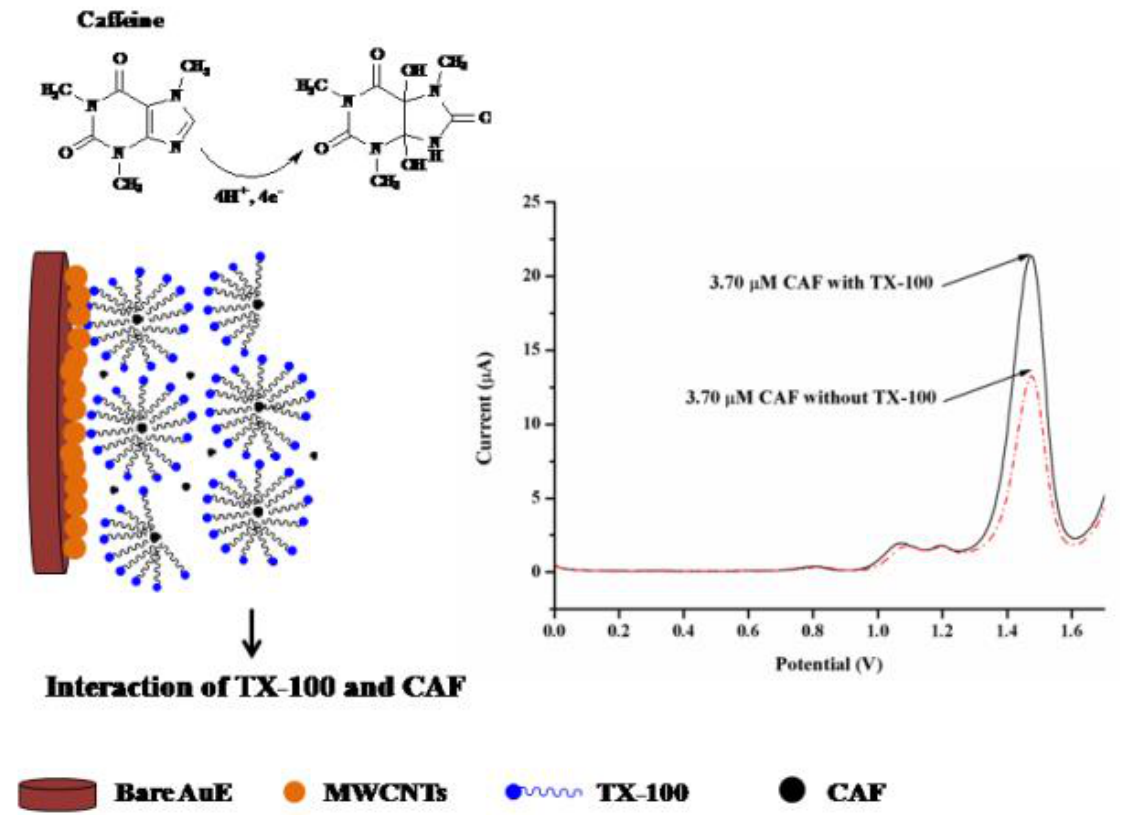
Figure 6. Illustration of interaction of CF with TX-100 ·· MWCNTs/Au electrode and corresponding DPV of CF in in 0.1M acetate buffer (pH 3.0) at a scan rate of 50 mV/s without TX-100 and with 10 µL of 10 mM TX-100. Reprinted from [98].